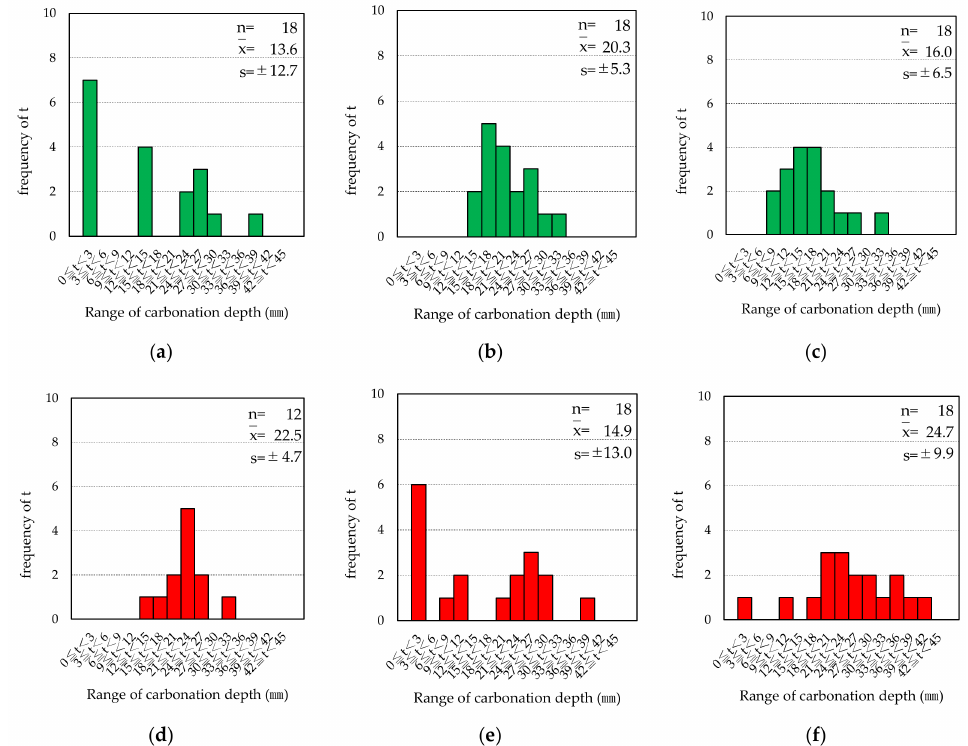
Figure 7. The distribution of the carbonation depth on the side of the foundation of Bldg. B.